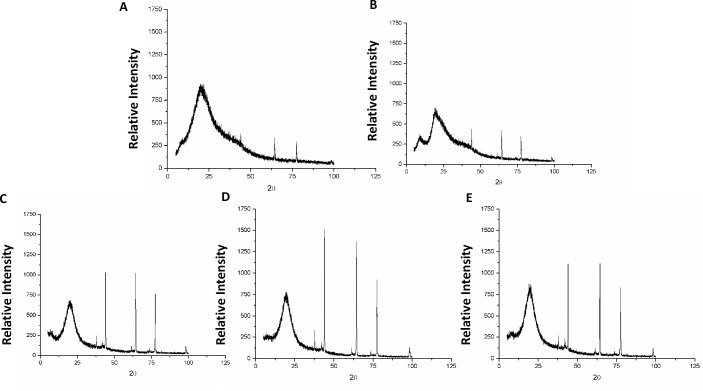
X-ray diffractograms of encapsulating agents and powder particles obtained by O/W emulsification technique.(A) porcine gelatin; (B) whey protein isolated; (C) OG: Quinoa oil and porcine gelatin in aqueous phase 2; (D) OWG1: Quinoa oil, whey protein isolate and porcine gelatin in aqueous phase 2; (E) OWG2: Quinoa oil, whey protein isolate in aqueous phase 1, and porcine gelatin in aqueous phase 2.